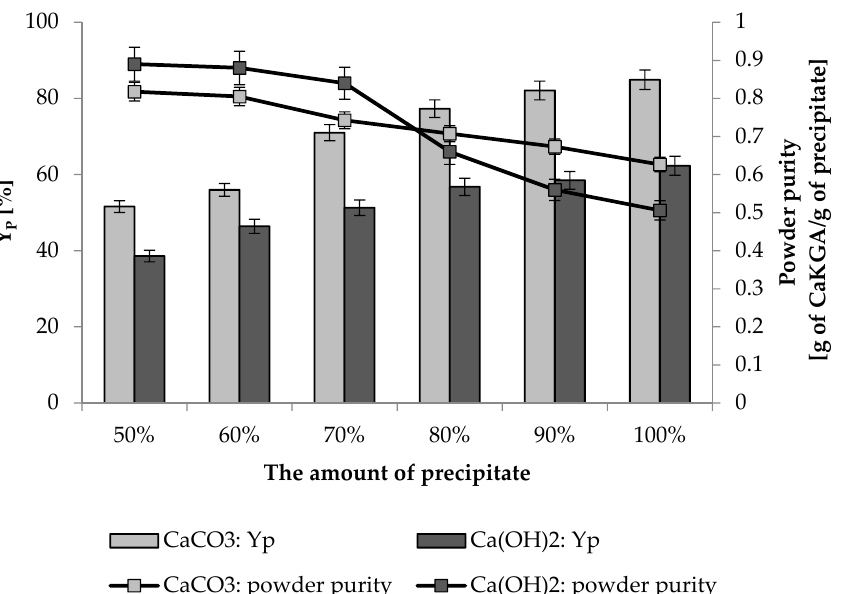
Figure 4. Yield of precipitation of KGA (Y P ) and purity of CaKGA powder obtained after precipitation by CaCO 3 or Ca(OH) 2 used in different amounts. Error bars represent the standard deviations of duplicates.